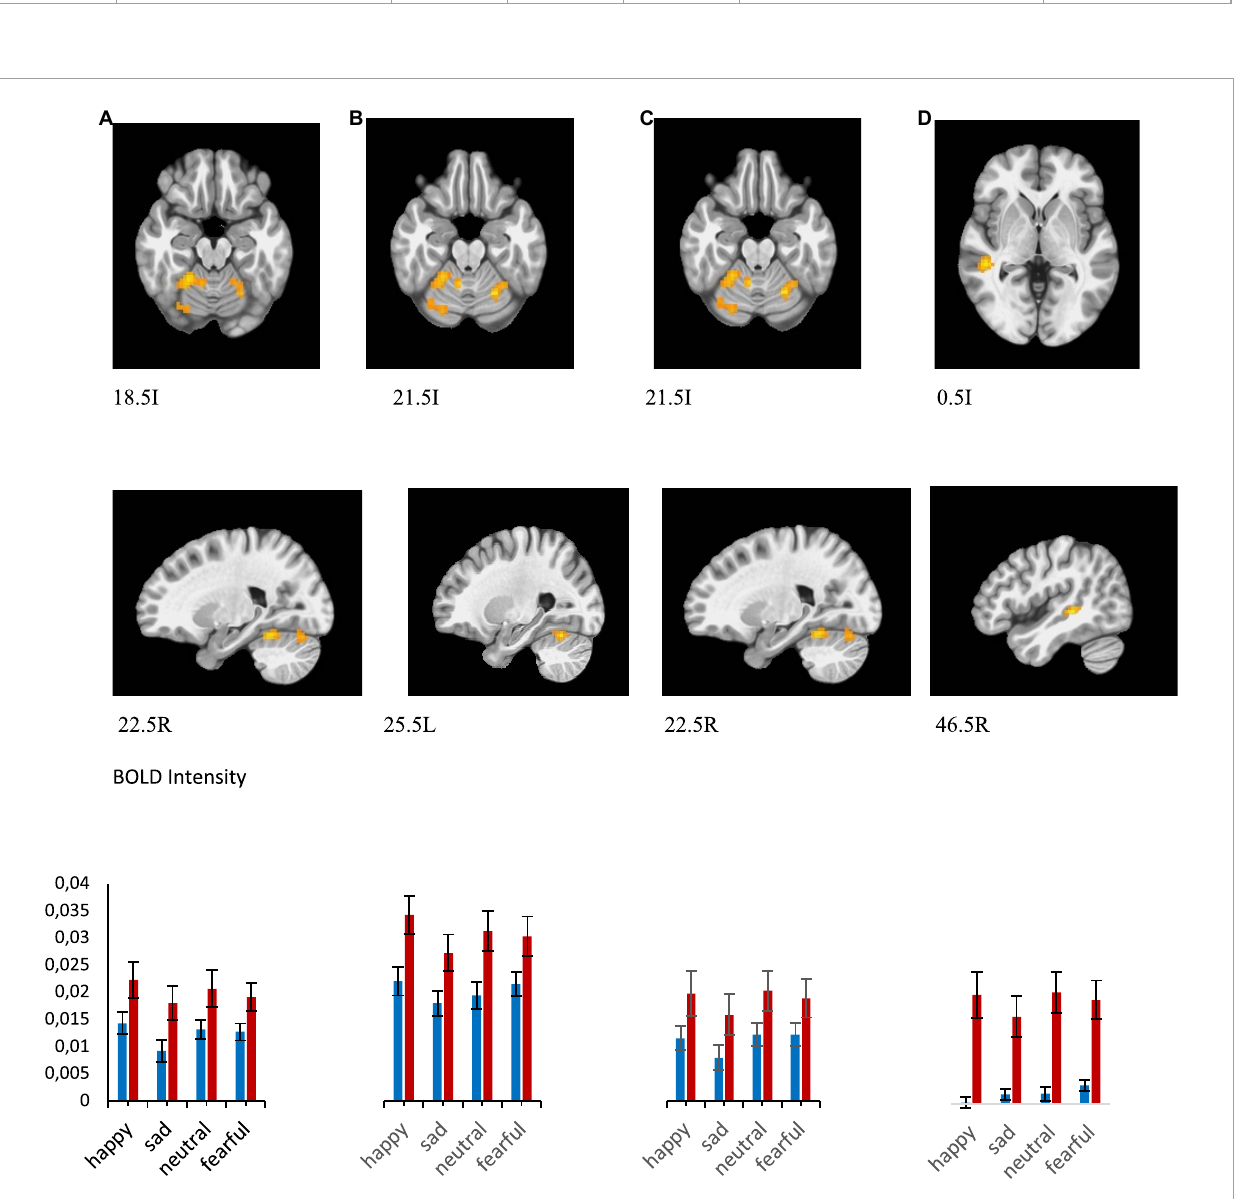
FIGURE5 Brain regions that showed significant emotion effect in all participants for presentations of happy, sad, fearful, and neutral faces [ (A) right culmen, happy > sad, Healthy > MDD, (B) left declive, happy > sad, Healthy > MDD, (C) right declive, (D) right middle temporal gyrus]. BOLD intensity during happy, sad, neutral, and fearful faces perception in MDD and Healthy groups in A and B brain areas ( p <